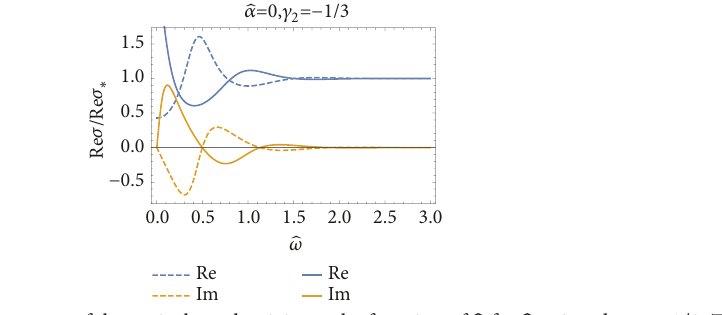
Figure 20: The real part and the imaginary part of the optical conductivity as the function of ̂𝜔 for ̂𝛼 = 0 and 𝛾 2 = −1/3 . The solid curves are the conductivity 𝜎 of the original EM theory (4) and the dashed curves display the conductivity 𝜎 ∗ of the EM dual theory (7).